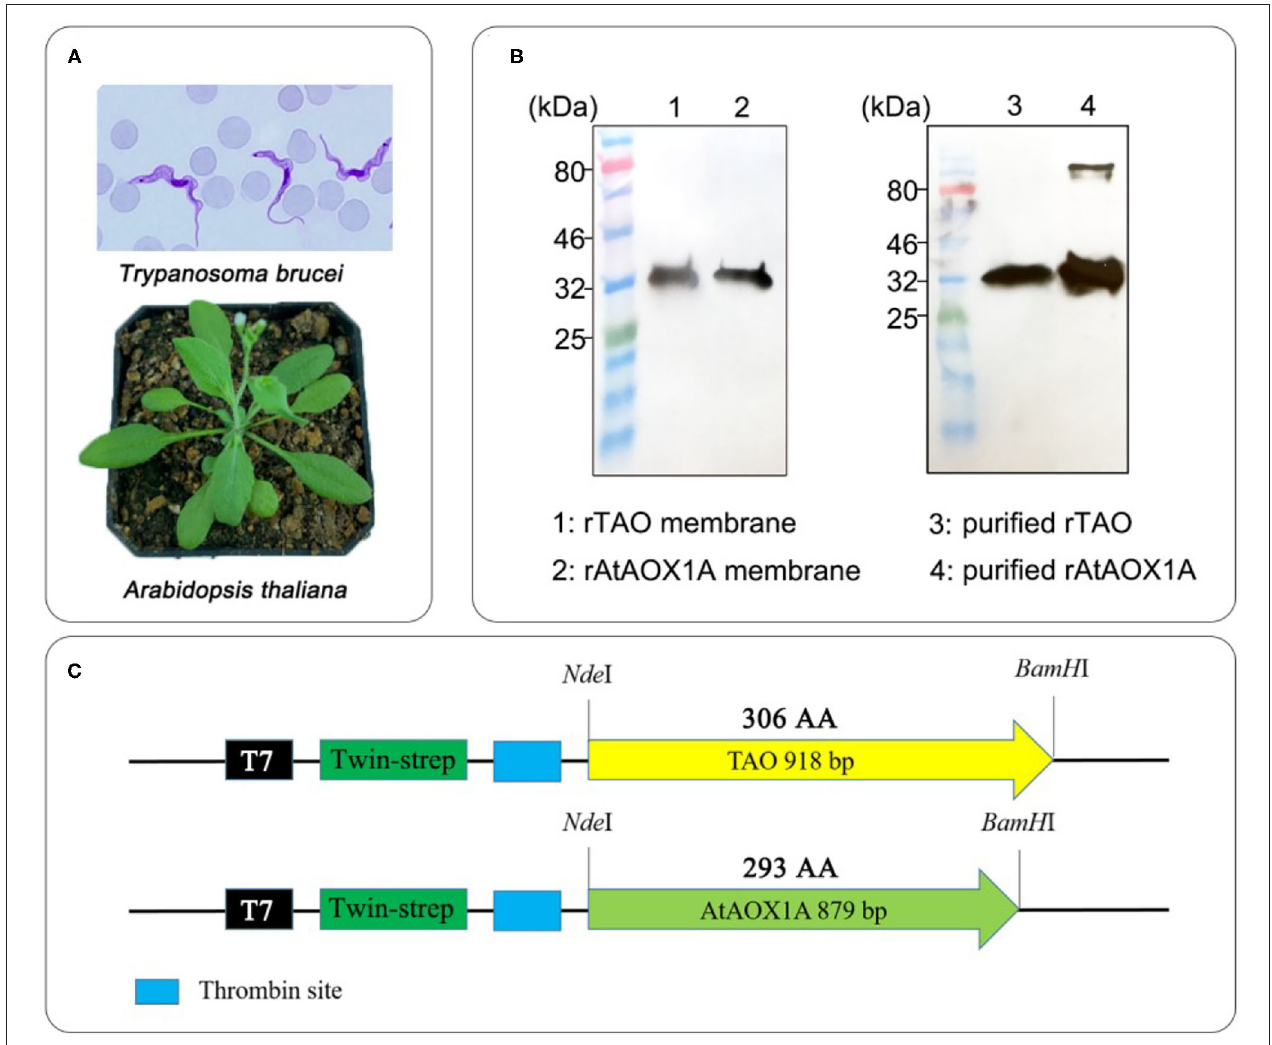
FIGURE 1 | Alternative oxidase (AOX) from Trypanosoma brucei and Arabidopsis thaliana . (A) Phenotypes of Trypanosoma brucei (from CDC) and A. thaliana . (B) Western blot results for membrane-bound proteins and purified AOXs. Within this experiment, 15 µ g of total membrane proteins and 1 µ g purified proteins were used for the Western blot. (C) Schematic diagram of recombinant expression vector construction for